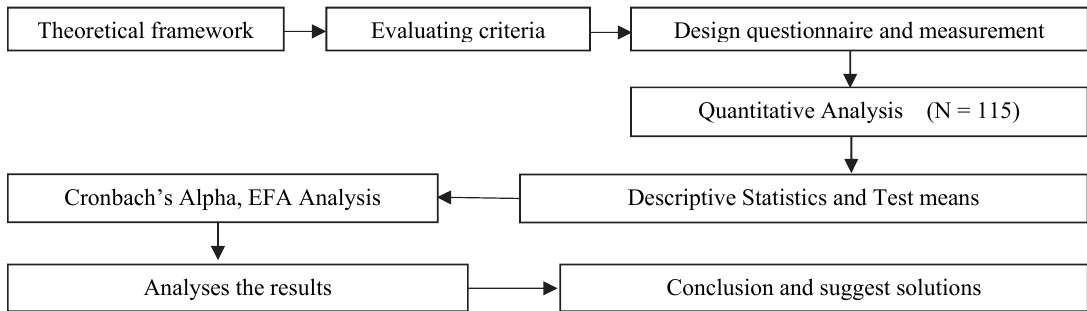
Fig. 1. The structure of the proposed study